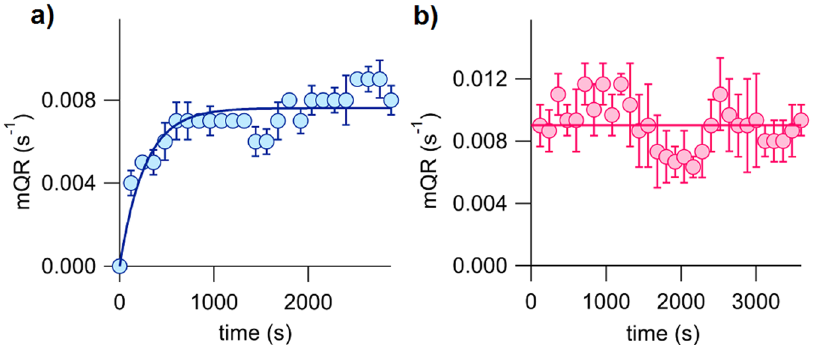
Figure 8. Time course of the incorporation and the stability of compound 1b in the plasma membrane. FTR- cells expressing the iodide-sensitive YFP protein were incubated in phosphate-buffered solution containing 137 mM NaCl. Iodide influx was estimated by the YFP fluorescence quenching upon addition of ICl to a final concentration of 100 mM. ( a ) Kinetics of the incorporation of compound 1b in the plasma membrane. The activity of the compound (at 12 µ M concentration) was measured, as maximum quenching rate, as function of time. ( b ) Stability of compound 1b in the plasma membrane. After 45 min incubation with 12 µ M 1b , cells were washed twice and the residual transport activity measured during 60 minutes. Symbols are means of 3 different experiments and vertical bars are standard error of the